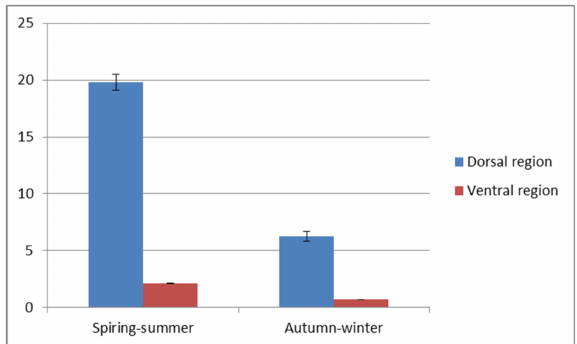
Figure 5. Presence of mucus cells (%) in the fish skin in the investigated